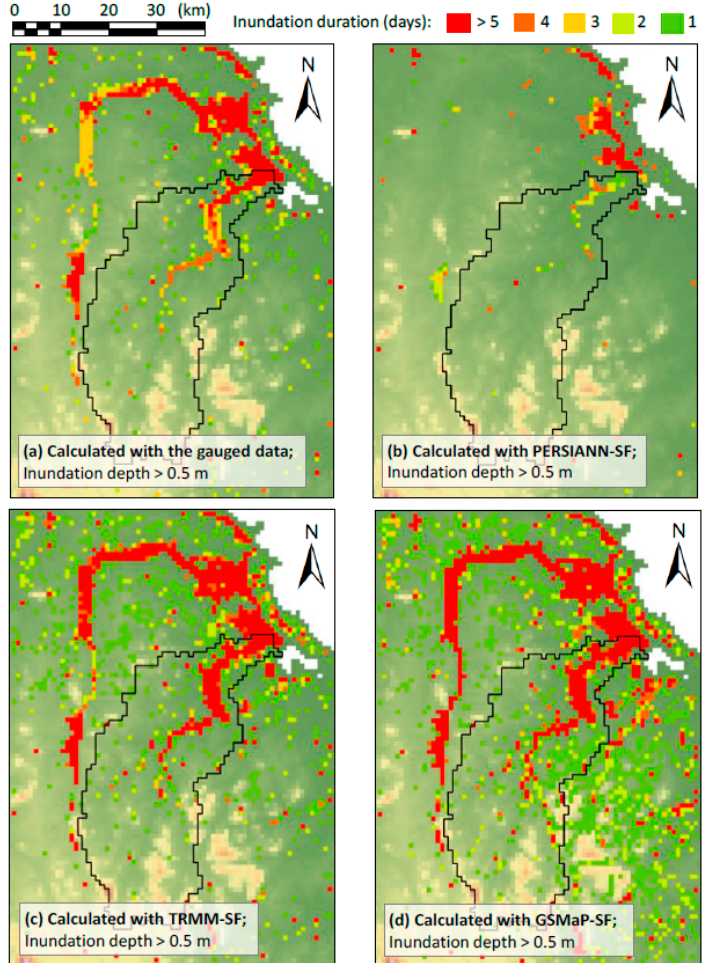
Figure 6. Distribution of maximum flood inundation duration from December 2010 to March 2011, calculated by the calibrated RRI model; ( a ) Gauged-R; ( b ) PERSIANN-SF; ( c ) TRMM-SF; and ( d ) GSMaP-SF.